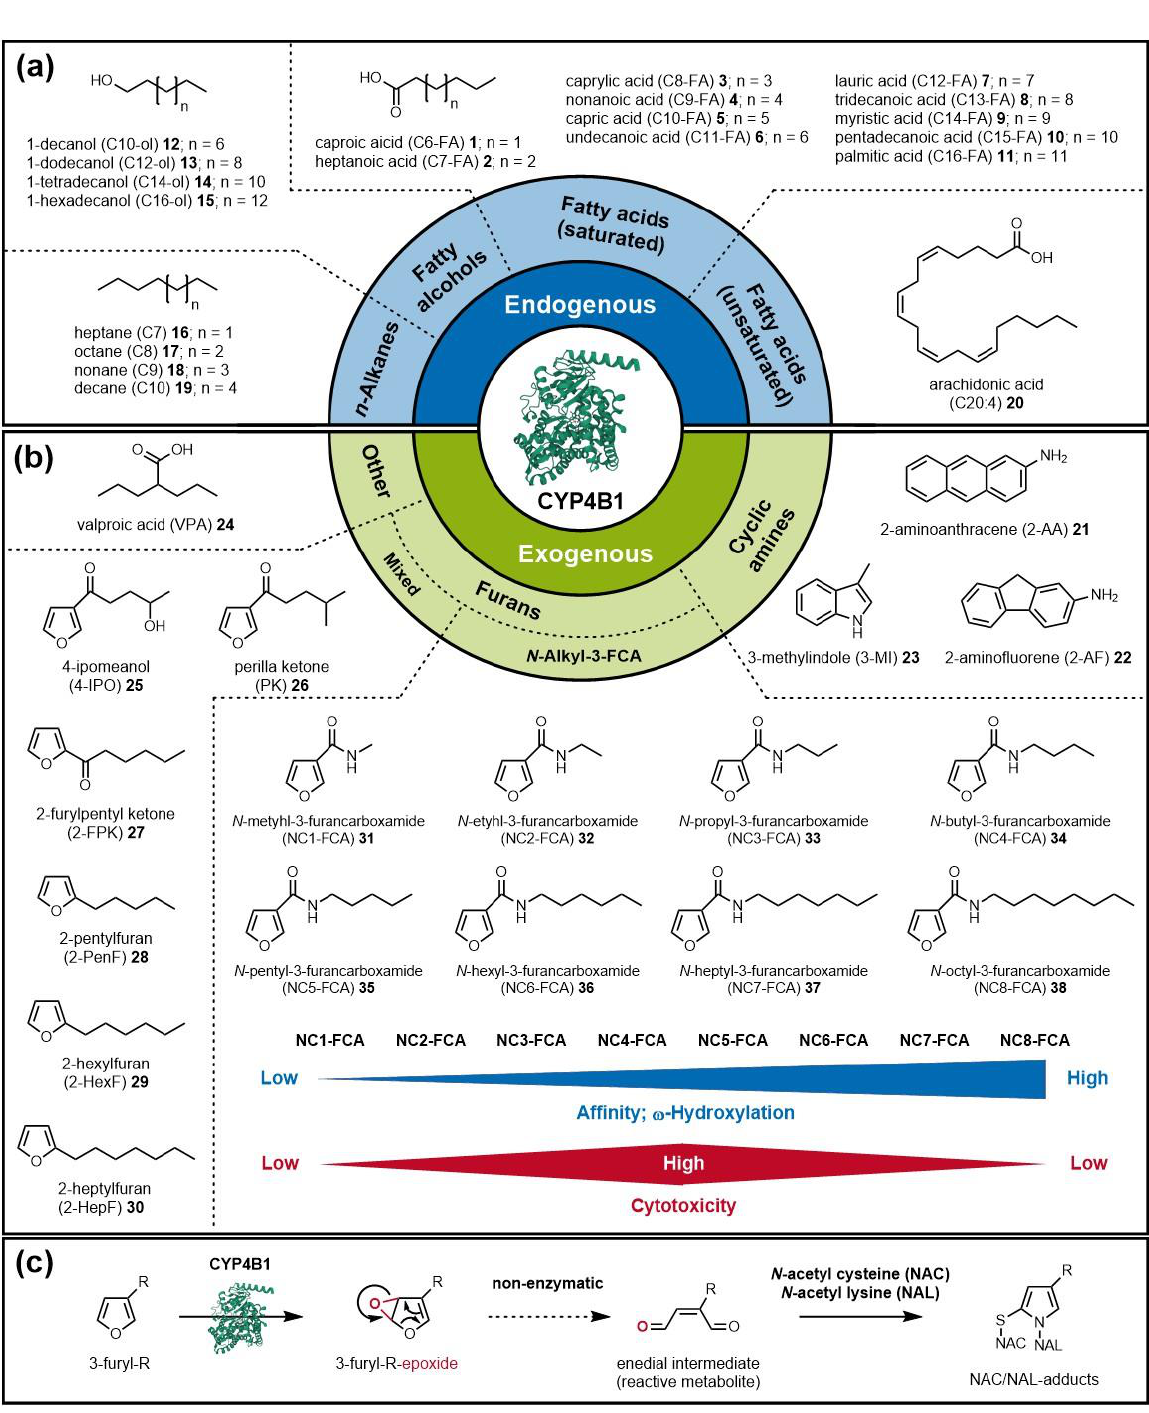
Figure 1. Overview of CYP4B1 substrates. ( a ) Endogenous substrates that are hydroxylated by CYP4B1 include fatty acids 1 – 11, 20 , fatty alcohols 12 – 15 , and n -alkanes 16 – 19 . ( b ) Exogenous sub- strates of CYP4B1 can be grouped into cyclic amines 21 – 23 , VPA 24 , and furyl-containing compounds 25 – 38 . ( c ) Schematic representation of the bioactivation pathway of 3-furyl-containing com- pounds 25, 26, 31 – 38 . CYP4B1 catalyzes the epoxidation of the furan ring, followed by non-enzy- matic rearrangement to an enedial intermediate. In vivo, these reactive enedial intermediates bind to macromolecules (e.g., proteins) causing cytotoxicity; in vitro, they can be trapped by reactions with nitrogen and sulfur nucleophiles (e.g., NAC/NAL) that generate stable S-substituted pyrroles.